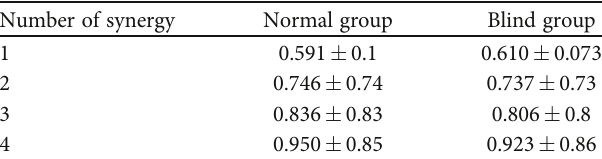
T ABLE 2: VAF of control group and blind group for different number of synergy.